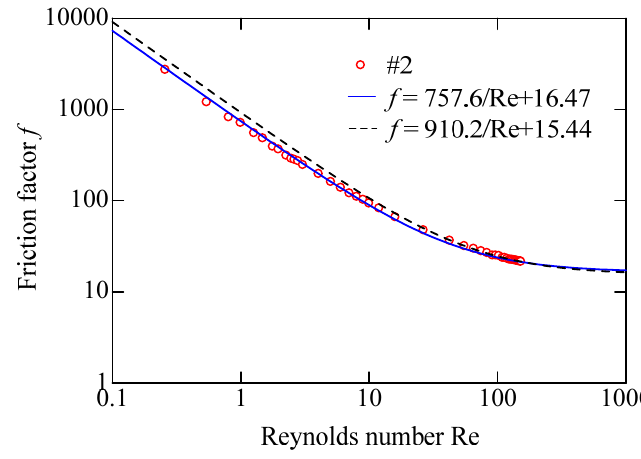
Figure 7. Relation between friction factor and Reynolds number